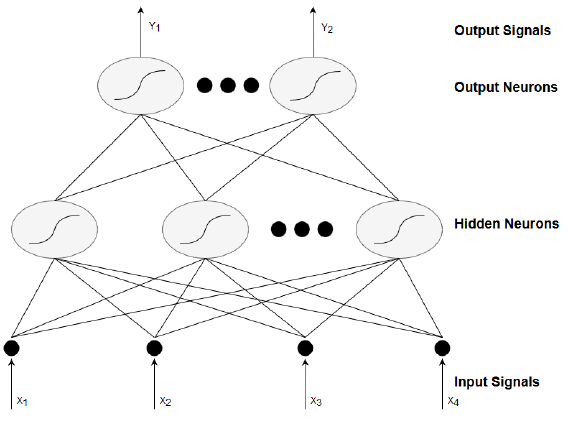
Figure 2. A neural network example consisting of two interconnected layers